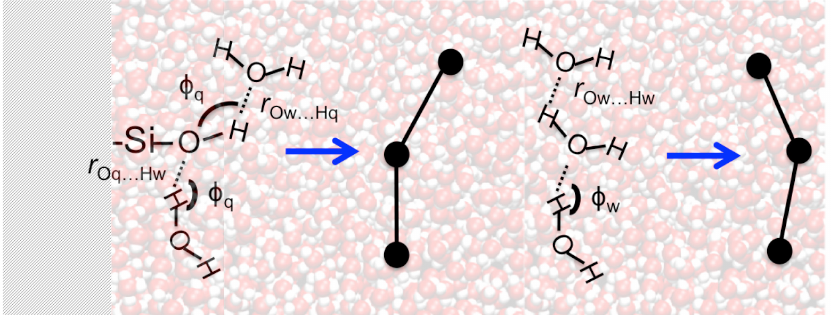
Figure 2. Definition of the intermolecular hydrogen bonds utilized to convert the simulation trajectories into a graph. On the left: water-silanol H-bond parameters. On the right: water-water H-bond parameters.